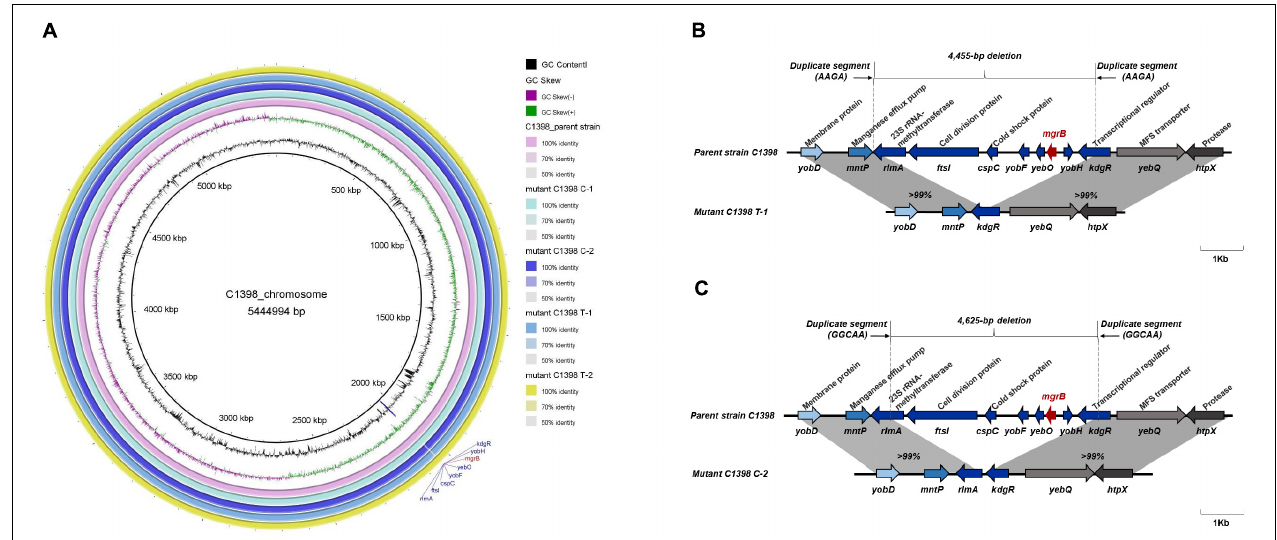
FIGURE 4 | Comparative analysis of the chromosome sequences among the parental strain C1398 and its mutants. The mutants from the fifth day of colistin selection are called C1398 C-1 and C1398 C-2, while the mutants from the tigecycline selection are called C1398 T-1 and C1398 T-2. (A) Alignment analysis of chromosome sequences of the parental strain C1398 and its corresponding mutants. (B,C) A ∼ 4.4 and 4.6 kb deletion containing mgrB locus and several other genes, including the transcriptional regulator kdgR , yobH , yebO , yobF , cold shock protein gene cspC , cell division protein gene ftsI , and rlmA were identified in mutant C1398 T-1 and mutant C1398 C-2,